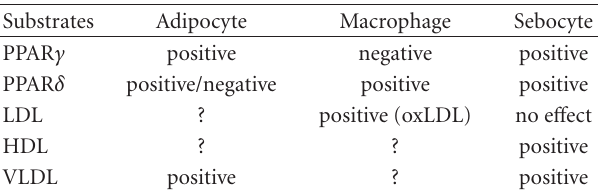
Table 2: Comparison of e ff ects of PPAR agonists and lipoproteins on lipid storage in adipocytes, macrophages, and